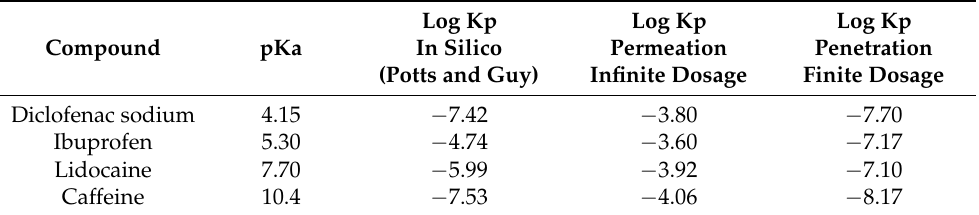
Table 5. The pKa, log Kp Potts and Guy, log Kp from the experimental infinite dose kinetic assay, and log Kp from the experimental finite dose percutaneous absorption assay. Log Compound pKa